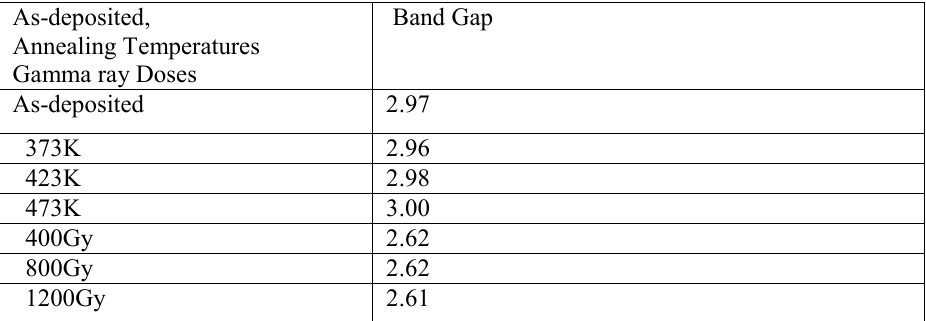
Table 1 . band gaps obtained for Cl FePc thin films annealed in air at various temperatures, 16 as-deposited and irradiated with various